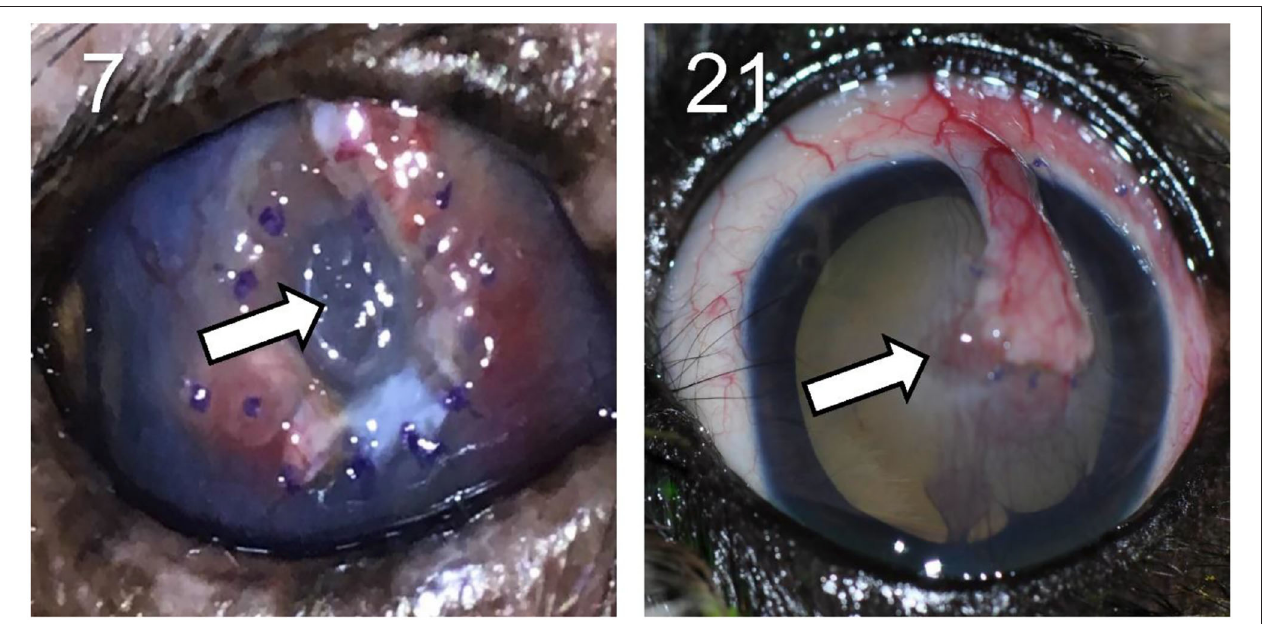
FIGURE 4 | Clinical photographs showing disintegration (left) and focal dehiscence (right) of the conjunctival pedicle flap surgically positioned at a previous visit in canine eyes with culture-confirmed bacterial keratitis. Patients ID are shown in the top left (see Table 1 for additional